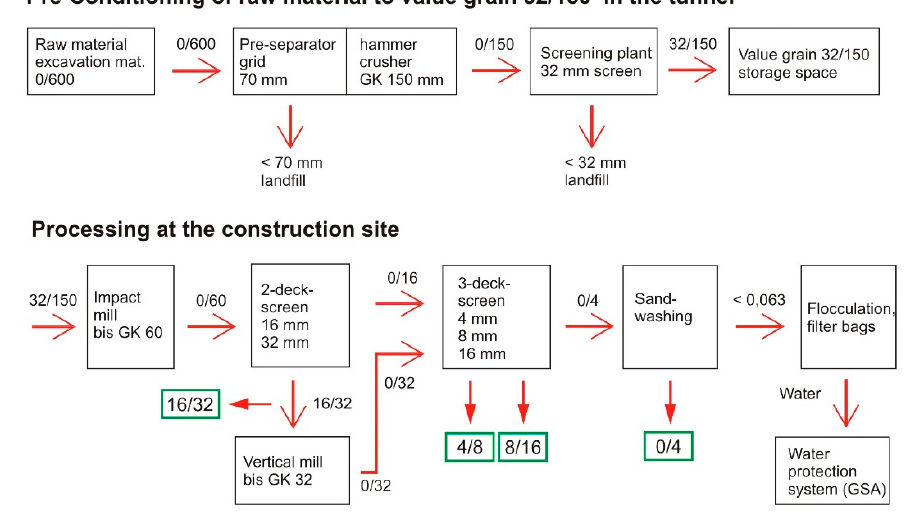
Figure 10. Processing concept of excavated tunnel spoil [39].